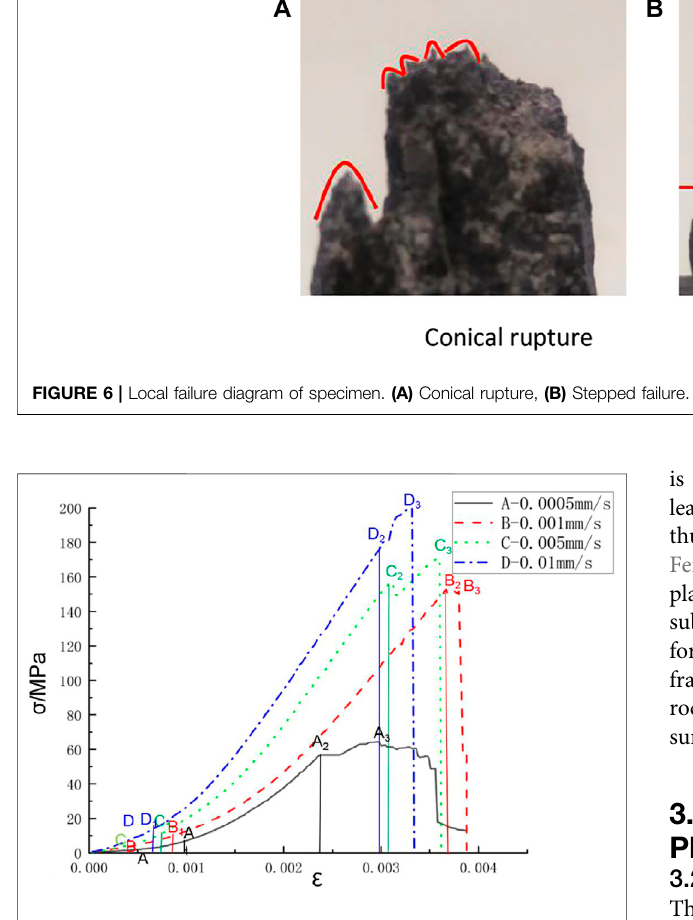
FIGURE 7 | Stress – strain curves of specimens under